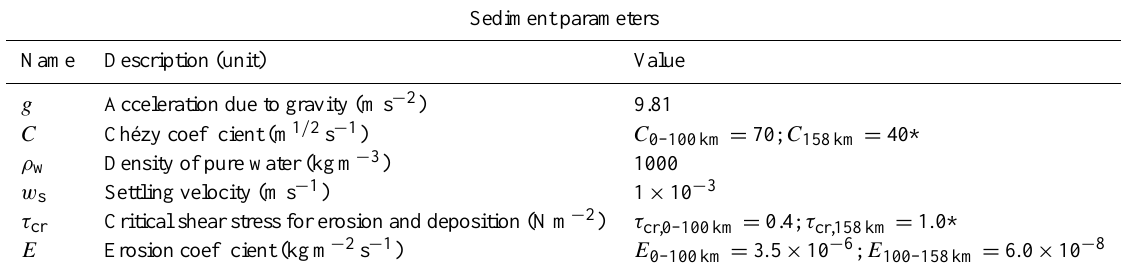
Table 5. Calibrated sediment parameters used in C-GEM for stationary and transient simulations. Note that a linear variation is applied to the Chézy coefficient ( C) and the critical shear stress for erosion and deposition ( τ cr ) between 100km and 158km is applied. Numerical values assigned to C 158 km and τ cr,158 km correspond to their value imposed at the estuarine upper